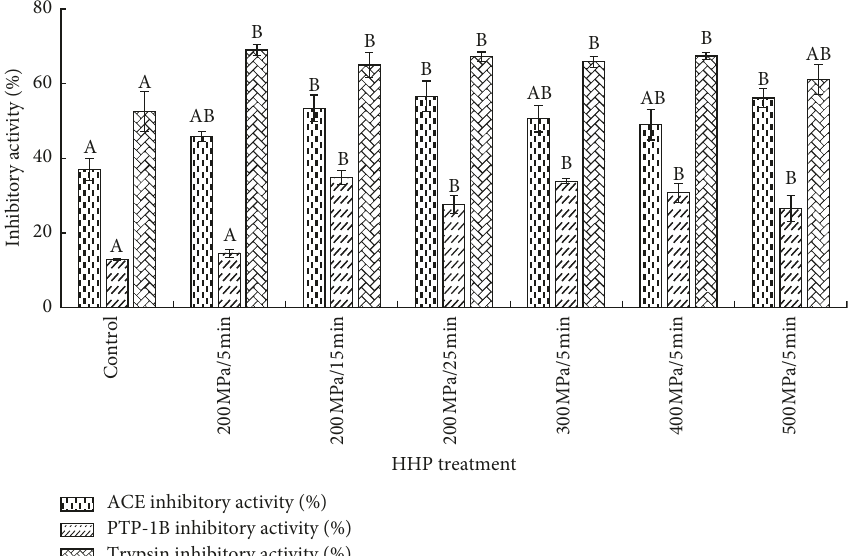
Figure 5: Enzyme inhibitory activities of melanoidins after different HHP treatments. Different uppercase letters in the same color bar indicate significant differences at the P < 0 . 05